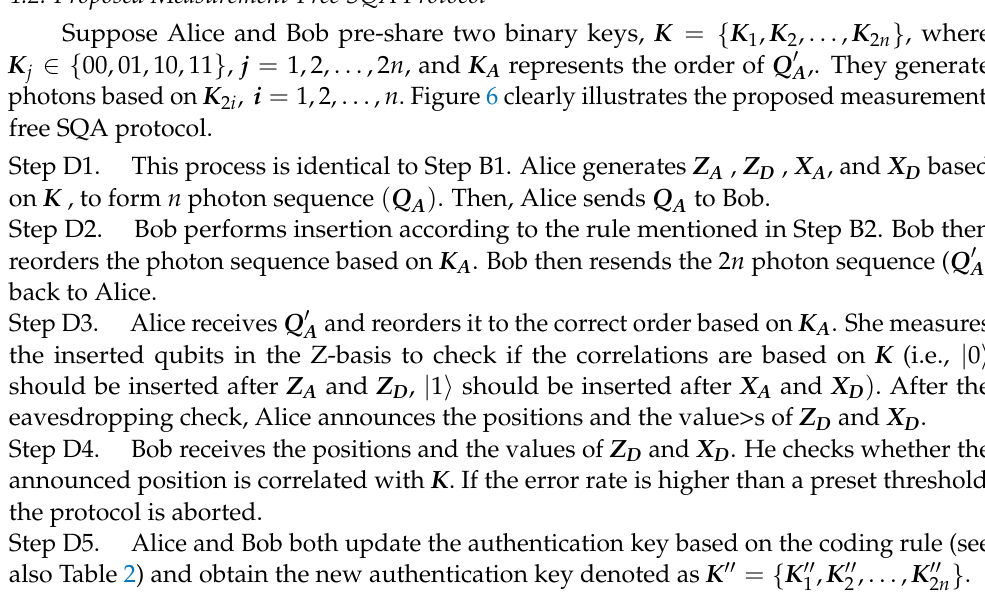
Table 2. Coding rule of K (cid:48)(cid:48) .